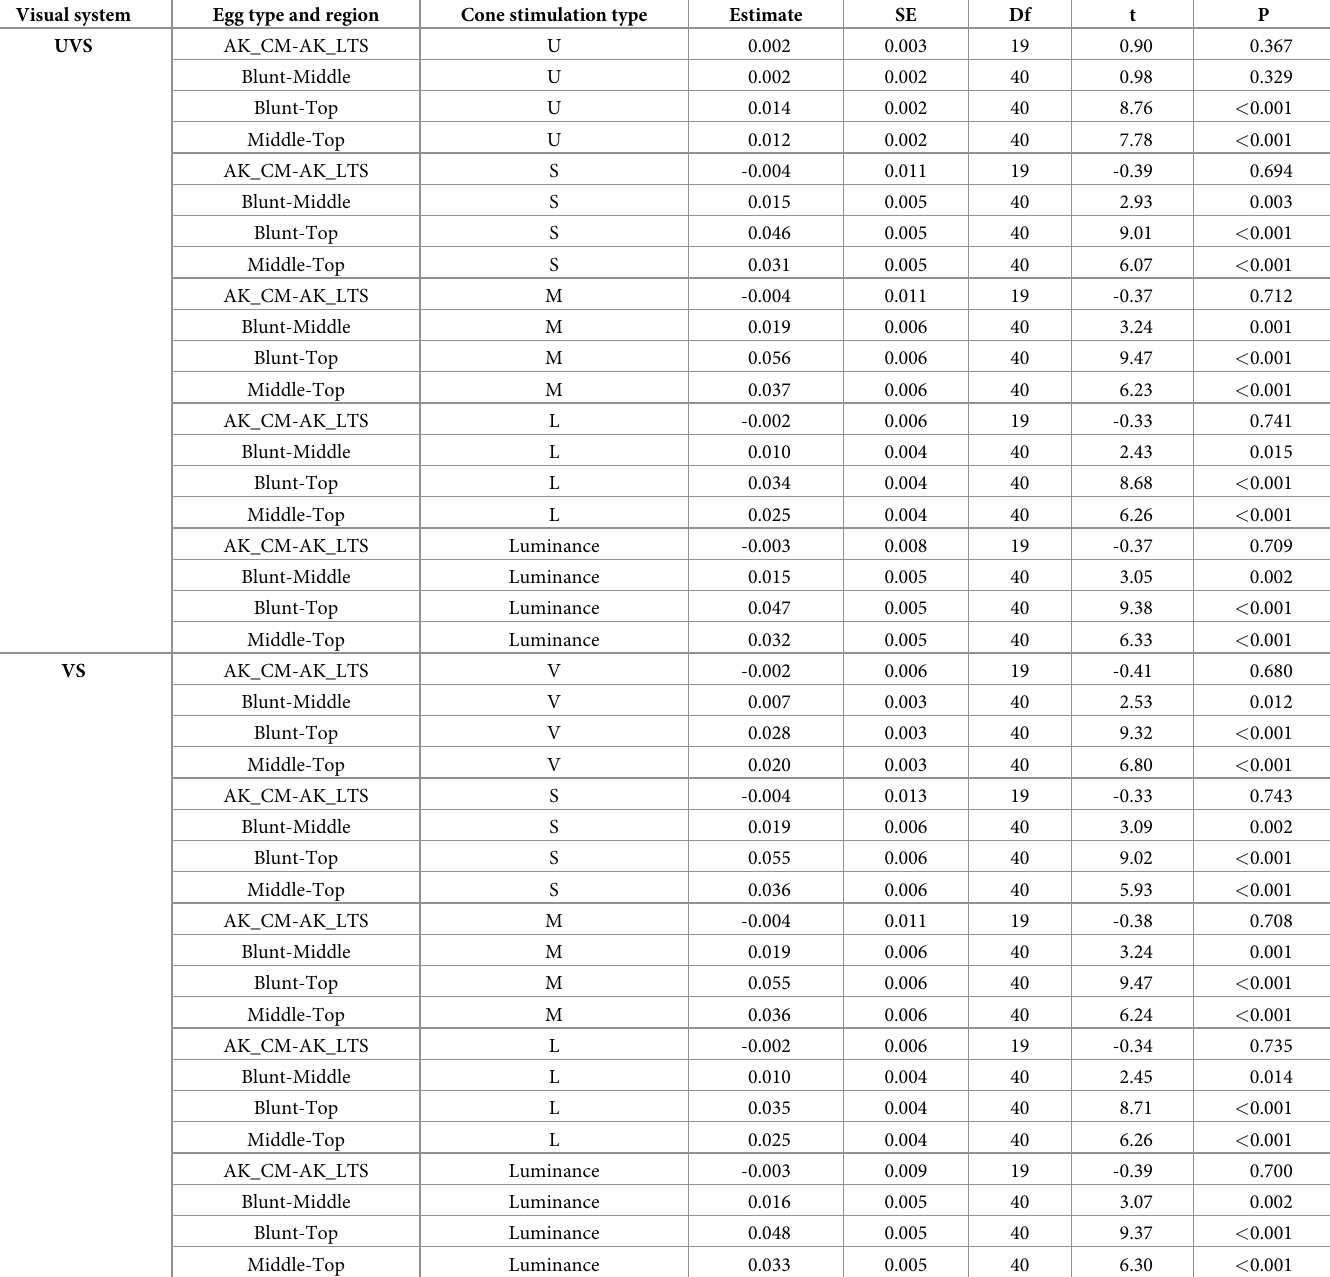
Table 2. Linear mixed effects model using cone stimulation values of Asian koel eggs as response, and host species (common myna and long-tailed shrike) and in different egg regions (blunt, middle, top) as fixed effects. Visual